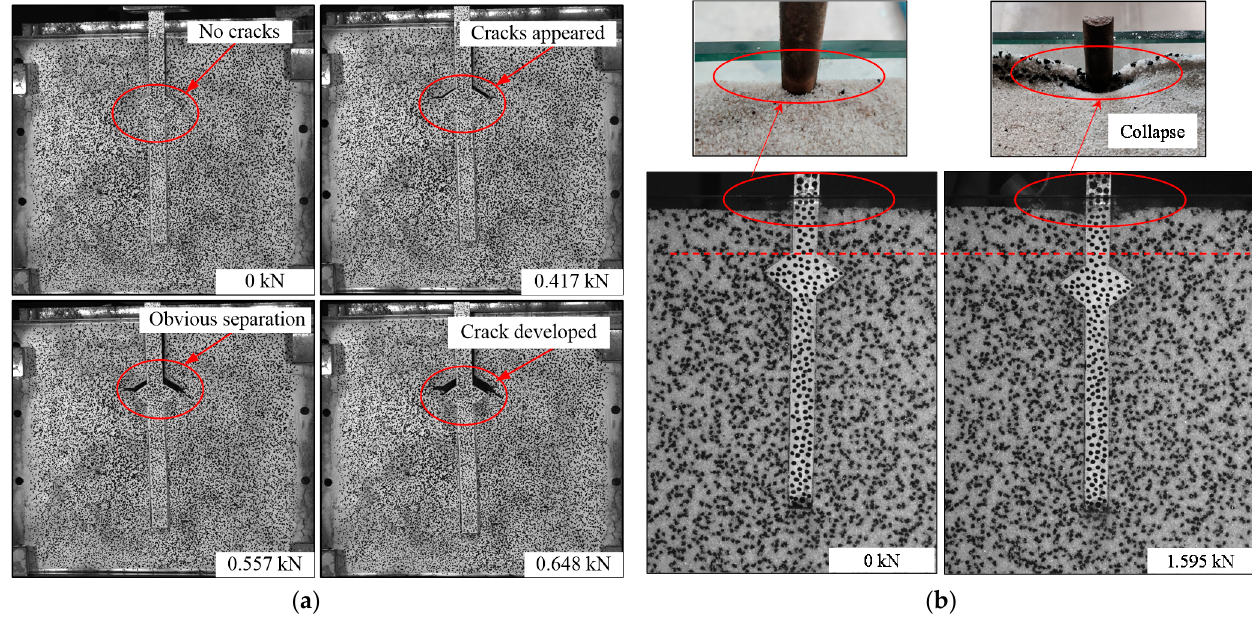
Figure 9. Surface images of the collection area under different loads: ( a ) undisturbed soil; ( b ) sand.